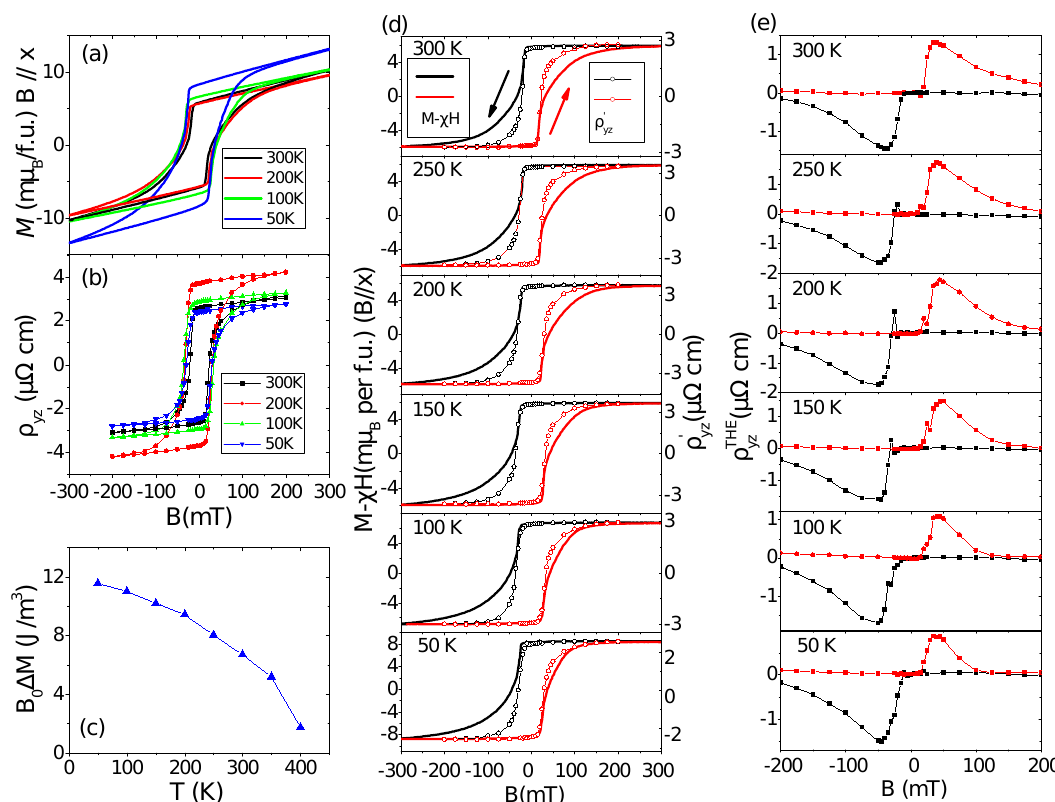
Figure 4: Magnetization, AHE and THE: a) Hysteretic loops of magnetization at different temperatures. b) Hysteretic loops of ρ at different temperatures. c) Tem- yz ∆ M , which represents the energy cost of staying single perature dependence of B 0 domain. d) Comparison of the magnetization, with its high-field slope subtracted, and anomalous Hall resistivity. The threshold field B is identical but, at all tem- 0 peratures, the magnetization shows a slower variation towards saturation at the end of the hysteresis loop. e)‘Topological’ Hall effect resolved by subtracting normalized magnetization times a constant from the Hall resistivity at different temperatures. At the boundary of regimes II and III, a sizeable component of the AHE is due to inhomogeneous magnetization with an out-of-plane